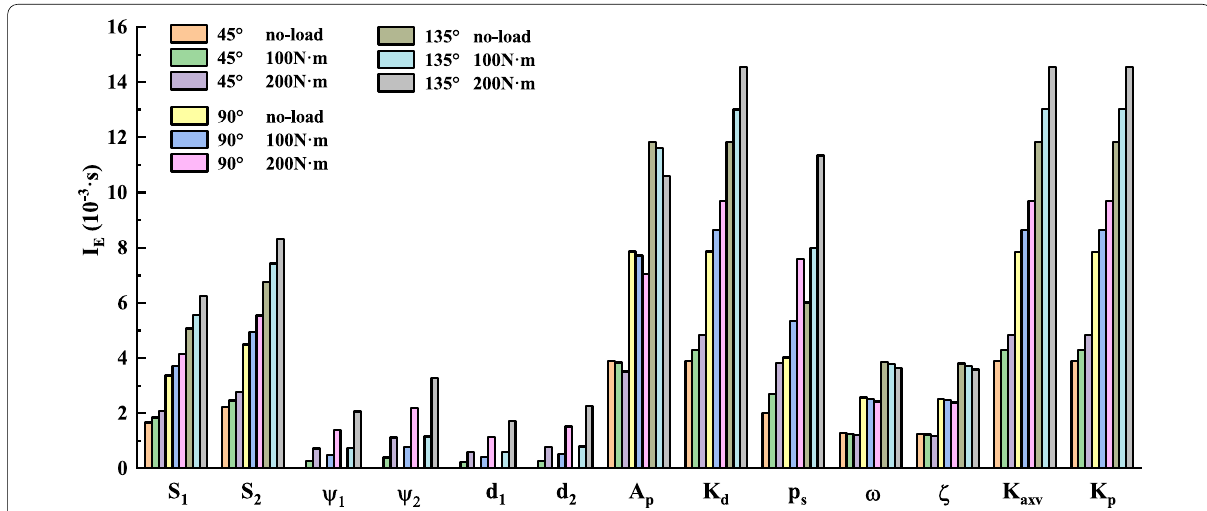
Figure 18 Histogram of sensitivity index corresponding to parameters under nine operating